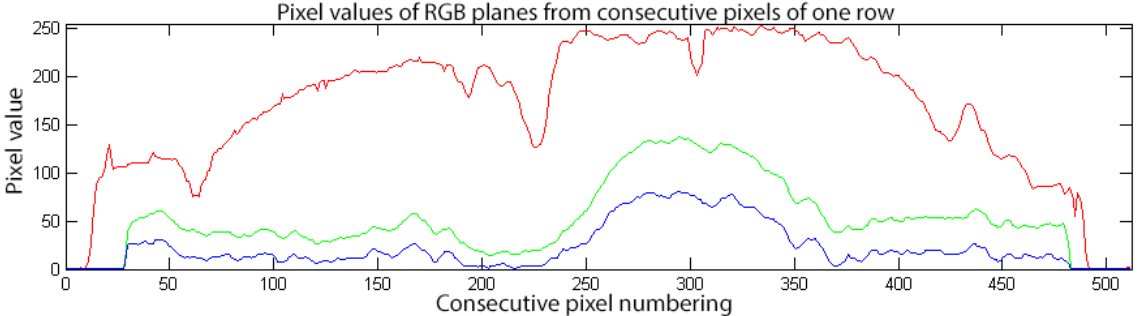
Figure 4. The RGB values of the pixel sequence on a single row of one capsule endoscopy image. It can be seen that Green and Blue components are much smoother than the Red component.